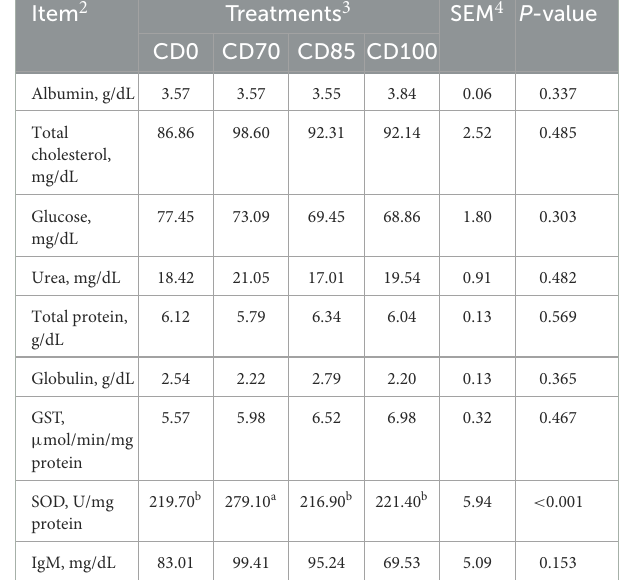
TABLE 4 Effect of β -mannanase supplementation in diets containing xylanase-phytase and reduced metabolizable energy on apparent